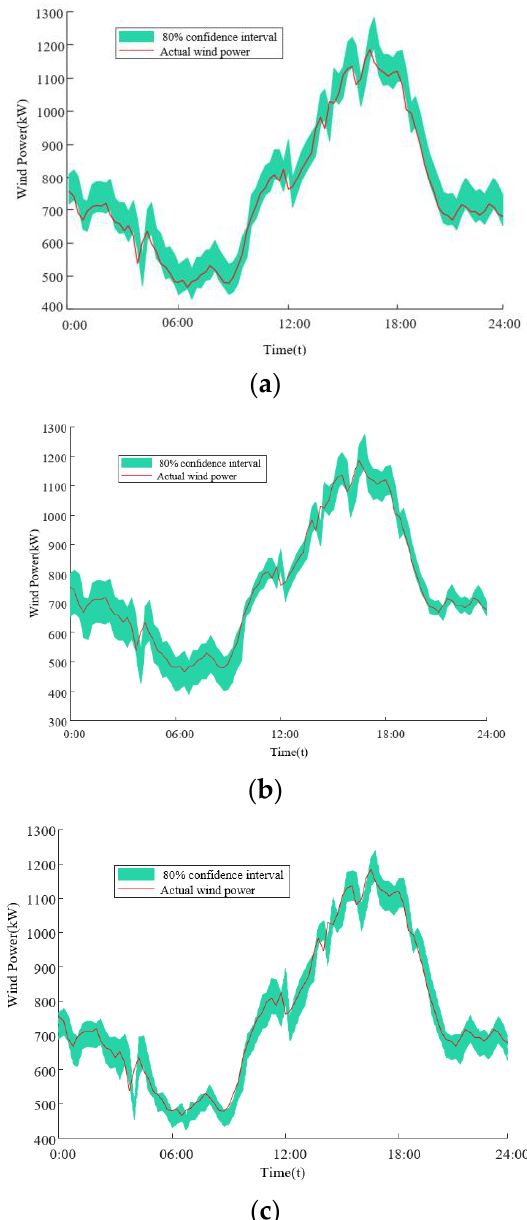
Figure 9. Prediction results of 80% confidence intervals for different methods: ( a ) method 1, ( b ) method 2, ( c ) the proposed method.